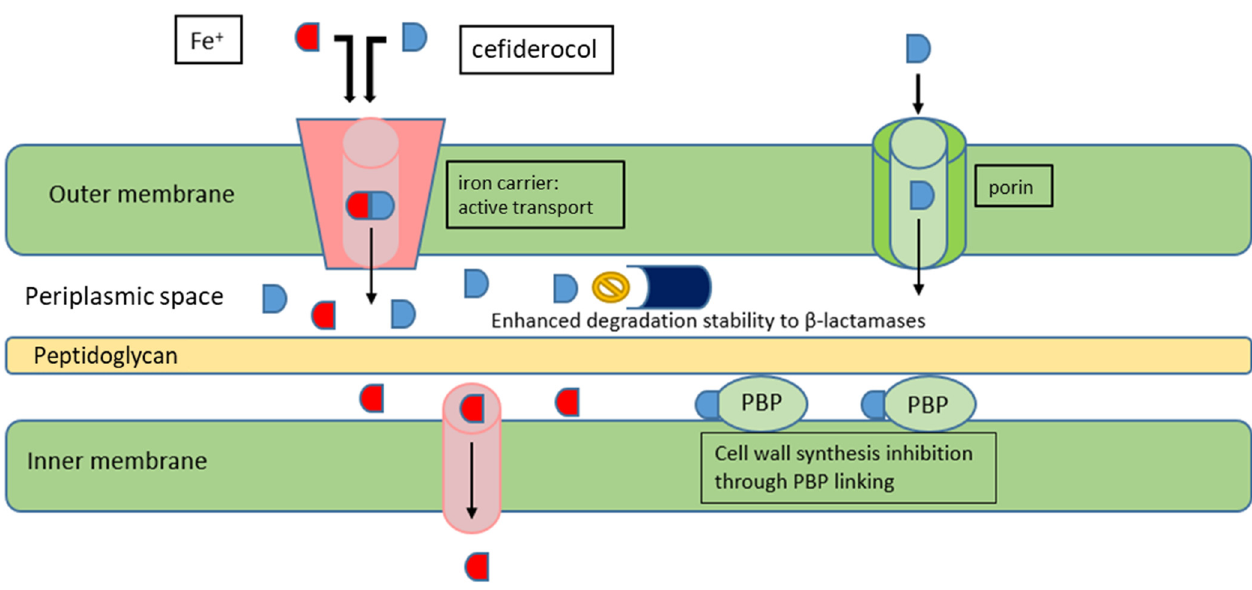
Figure 2. Mechanism of action of cefiderocol.